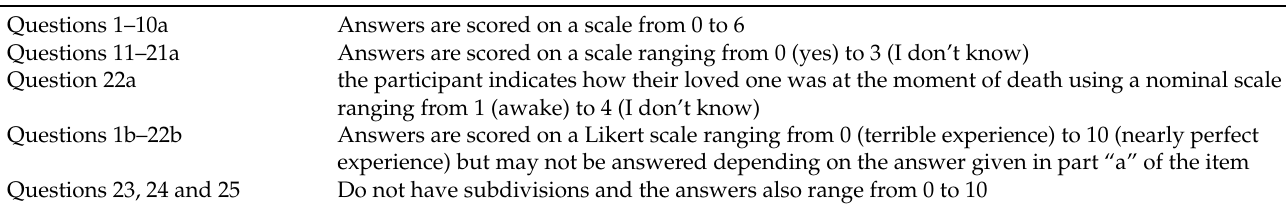
Table 1. Response options for the QODD